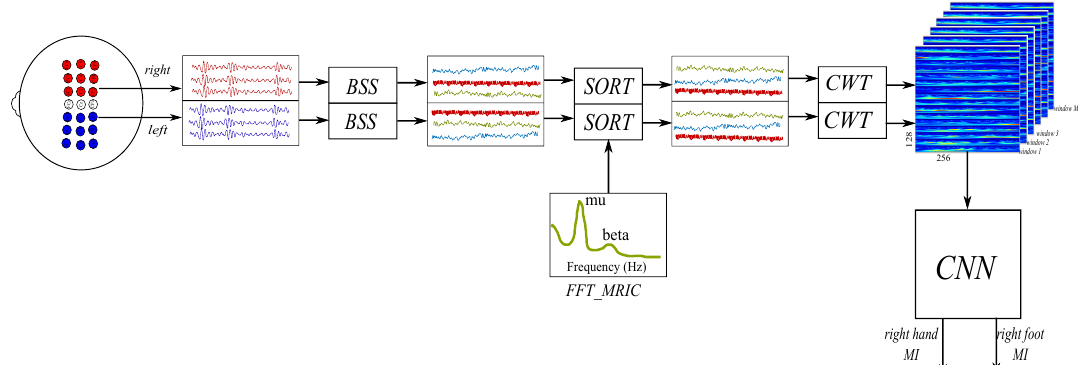
Figure 2. Proposed methodology. The left and right channels are prepossessed using a BSS algorithm, the MRIC sorts the estimated sources, in the CWT stage the images for each time window are obtained, finally the CNN separates the classes.